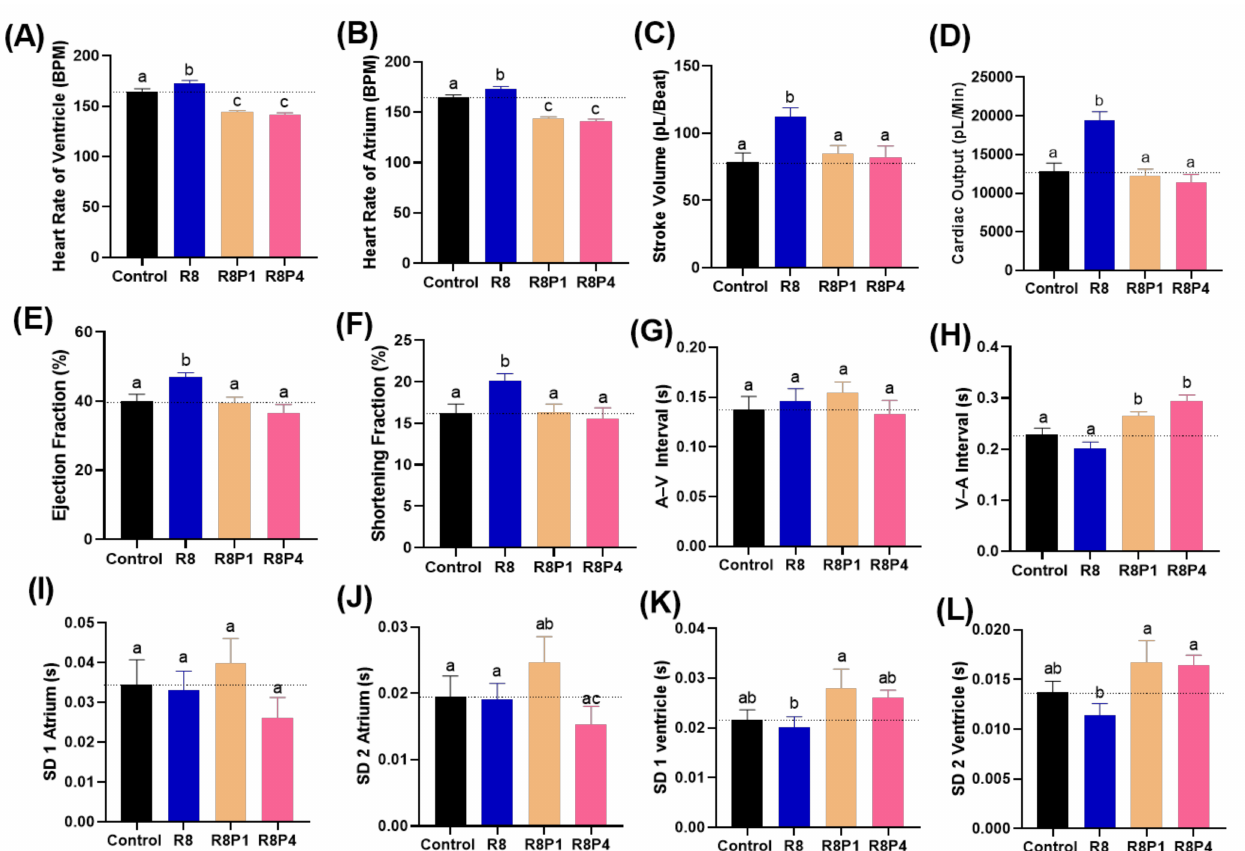
Figure 8. Cardiac physiology alterations of zebrafish larvae at 72 hpf after co-incubation of RAC and PROP at different doses. Several important endpoints like: ( A ) heart rate in the ventricle, ( B ) heart rate in the atrium, ( C ) stroke volume, ( D ) cardiac output, ( E ) ejection fraction and ( F ) shortening fraction ( G ) A–V interval, ( H ) V–A interval, ( I ) SD of Poincare plot in 1 atrium, ( J ) SD 2 of Poincare plot in atrium, ( K ) SD 1 of Poincare plot in ventricle, and ( L ) SD 2 of Poincare plot in ventricle were measured and compared. The data are expressed as the means ± SEM and were analyzed either by one-way ANOVA followed with Fisher’s LSD test or Kruskal–Wallis test with Dunnett’s correction for multiple comparison test. Different letters a, b, and c above columns indicate significant statistical differences with p < 0.05 ( n = 20–22). Abbreviations: R8 (RAC 8 ppm), R8P1 (RAC 8 ppm and PROP 1 ppm), and R8P4 (RAC 8 ppm and PROP 4 ppm). Black bar: control, blue bar: R8, cream bar: R8P1, and pink bar: